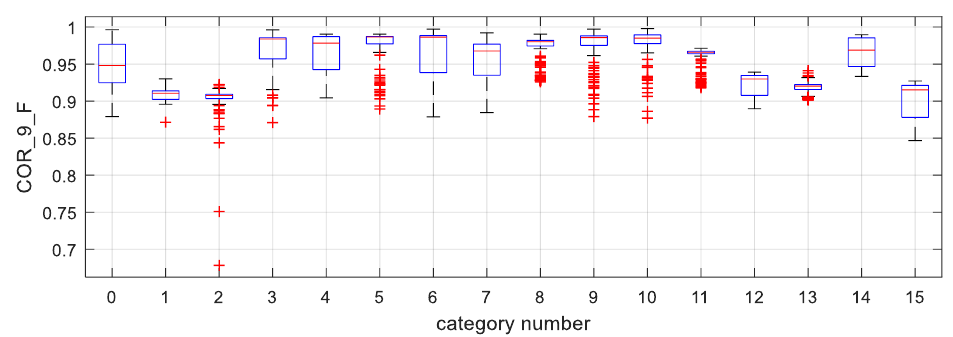
Figure 25. Box plot of feature COR_9_F.